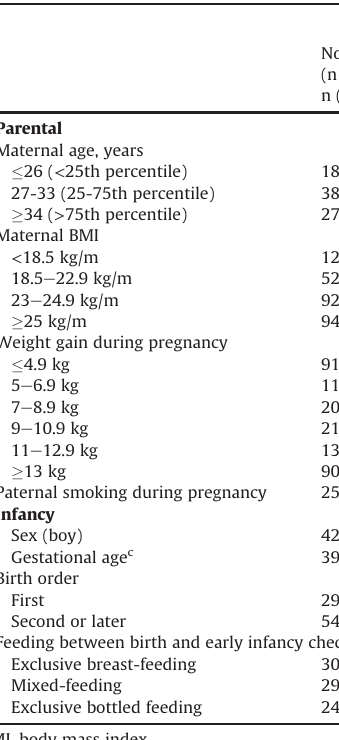
Table 1 Characteristics of the study population by maternal smoking during pregnancy.